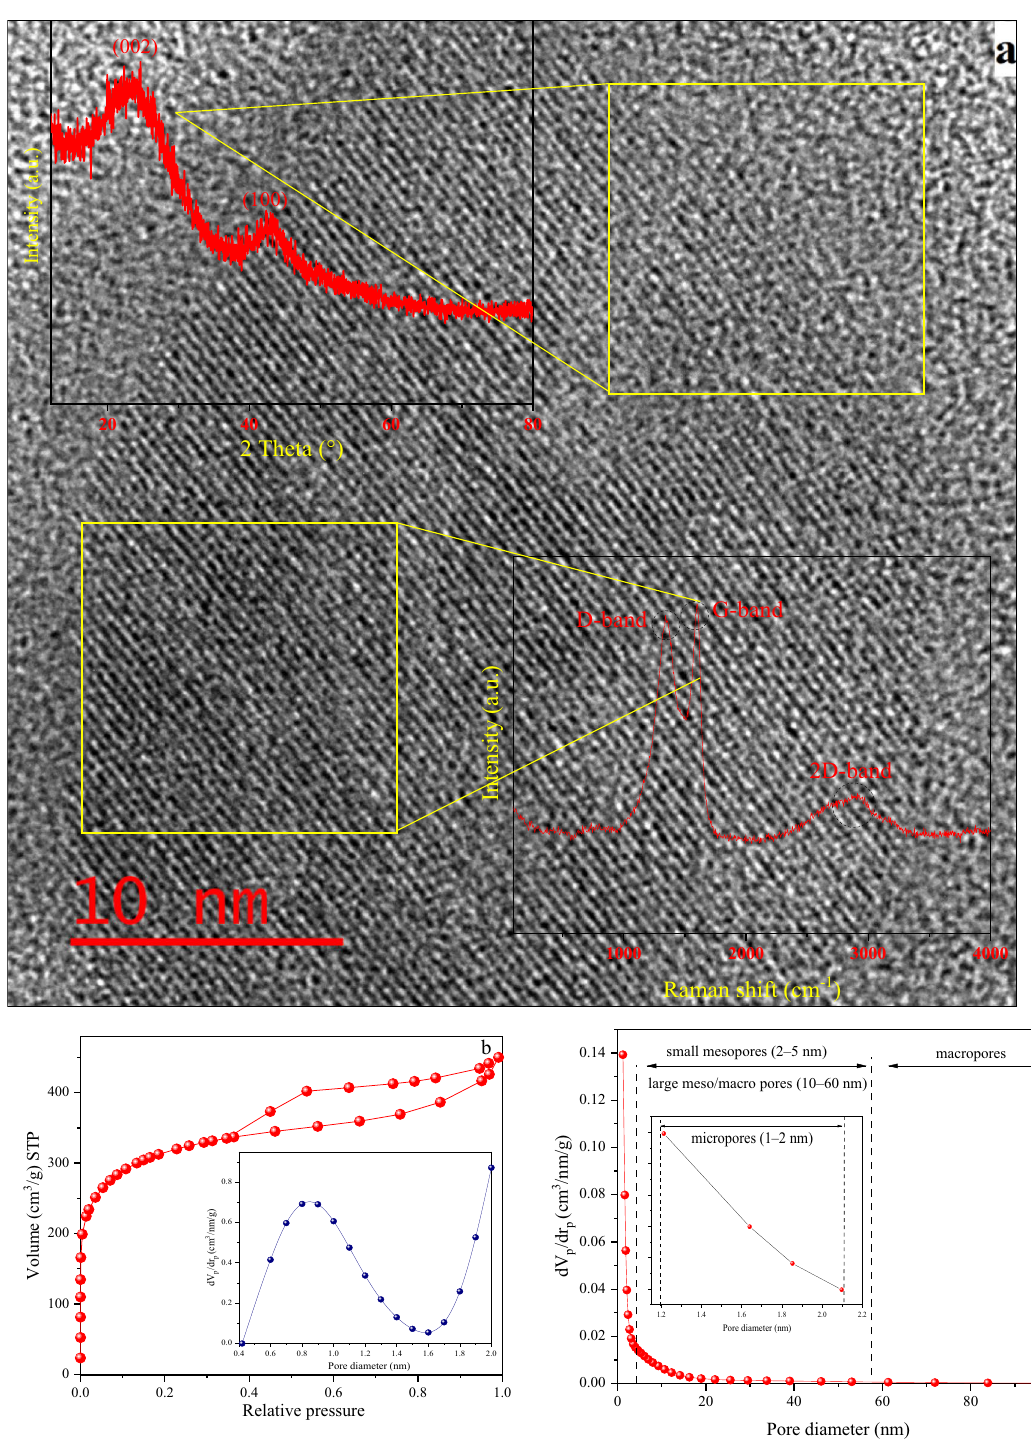
Figure 3. ( a ) XRD, HRTEM, Raman ( b ) N 2 adsorption/desorption isotherms; (b-inset) MP plots (pores smaller than 2 nm); ( c ) BJH pore size distributions curves; ( d ) FTIR transmission; ( e ) XPS survey spectrum showing the presence of C, N and O elements in the structure; ( f ) C1 s , ( g ) O1 s , and ( h ) N1 s peak deconvolution of